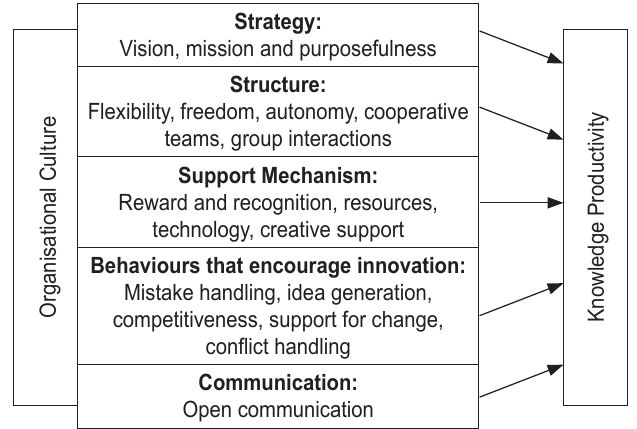
Figure 2: Parameters of organisational culture that